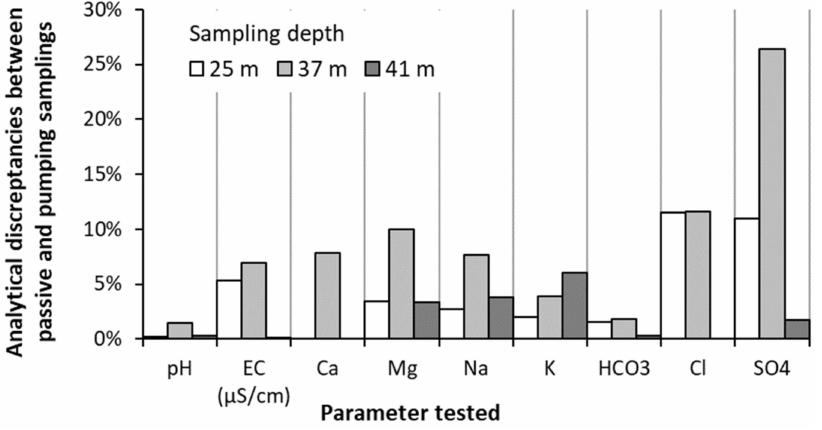
Figure 9. Analytical discrepancies between samples collected by passive samplers and those collected by low–flow pumping at different depths for the Chateauguay wellbore. Electroneutrality errors for the samples (Table 2) were all below 3.9%. Of the 33 com- parative measurements (11 parameters tested at three depths), the mean error is 2%. Four measurements of Cl − and SO 42 − at 25 and 37 m depths exceeded 10% of discrepancy